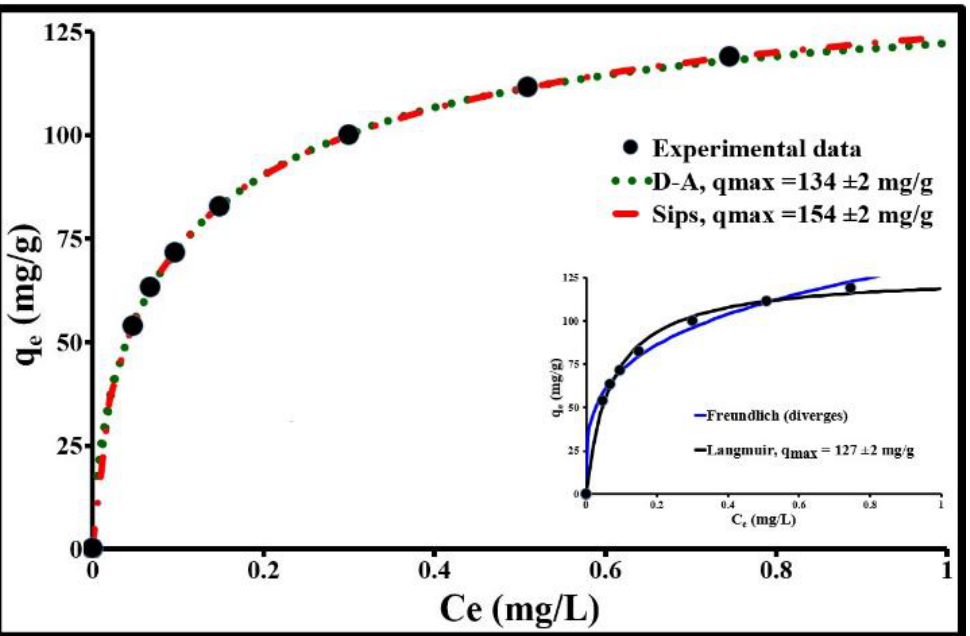
Figure 3. SMX adsorption isotherm on ACP Norit SA Super at pH 8.1 in tap water solution.